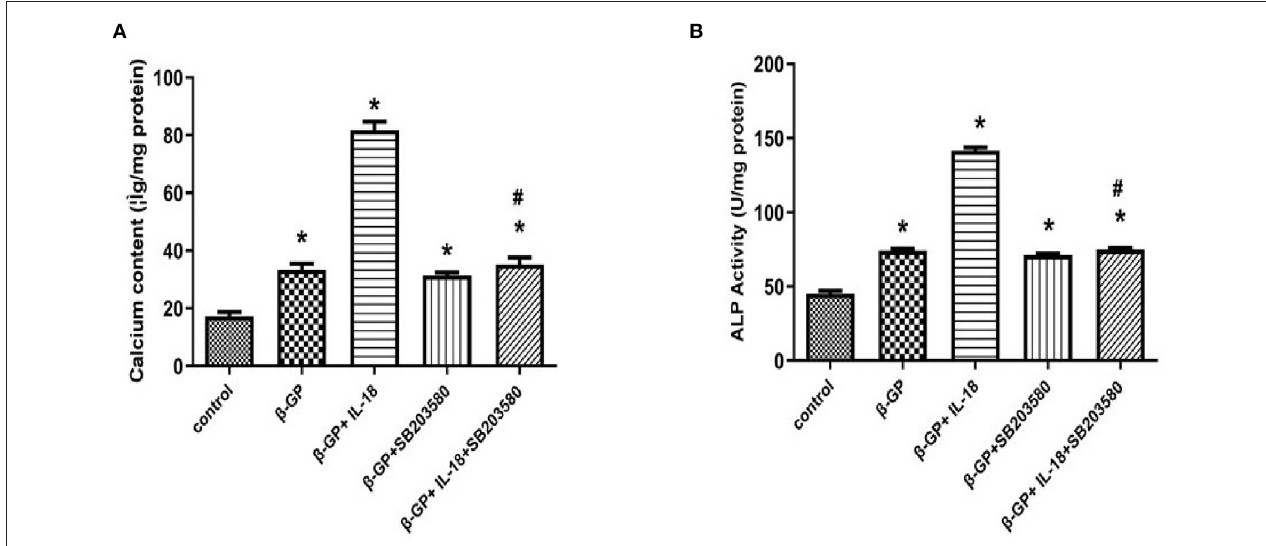
FIGURE 9 | Effect of p38 pathway on IL-18-induced calcification of rat VSMCs. (A) Effect of p38 pathway on calcium content of rat VSMCs after IL-18 intervention. (B) Effect of p38 pathway on ALP activity of rat VSMCs after IL-18 intervention. Rat VSMCs were pre-incubated with p38 inhibitor SB203580 (10 µ mol/L) for 2h, and